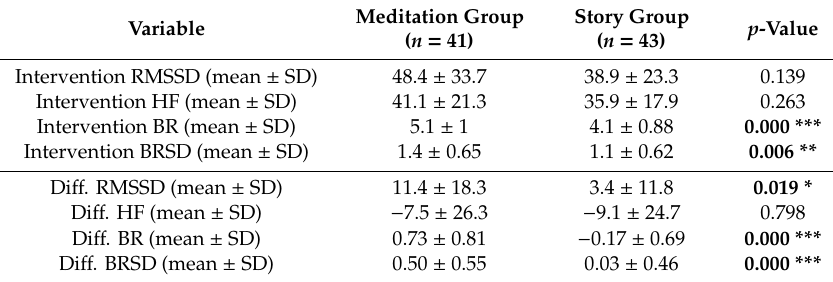
Figure 2. Illustration of the significant X  M relation ( a path) and the significant direct effect ( c’ path in red color ) and indirect effects ( ab paths) obtained by the mediation analysis with n = 84. The direction of the effects is pictured with + for a positive relation and − for a negative one.